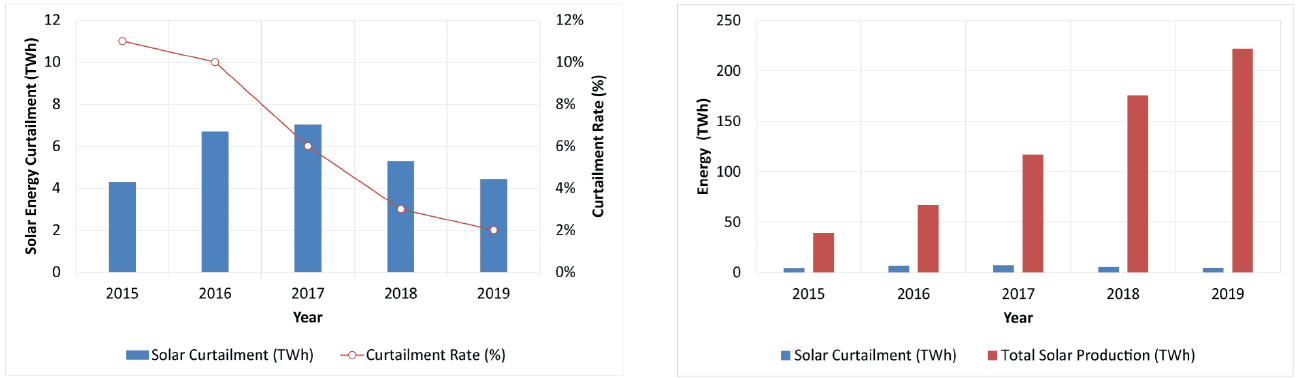
Figure 7. Solar PV energy curtailment in China 2015–2019: curtailed energy production and curtail-